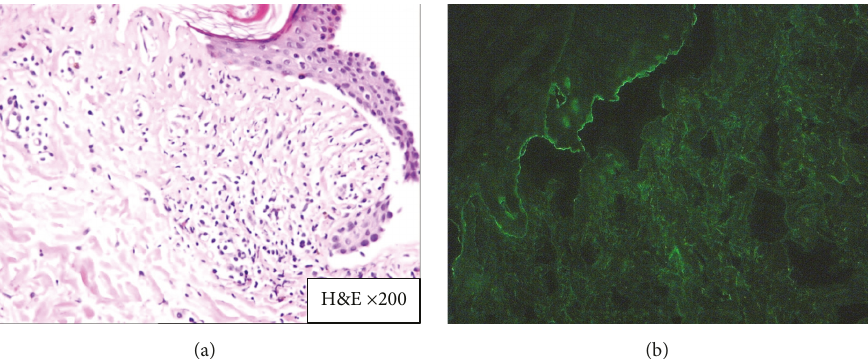
Figure 2: (a) Subepidermal blisters with eosinophilic infiltration (H&E × 200). (b) BIOCHIP demonstrated epidermal deposition on the salt-split skin substrate.